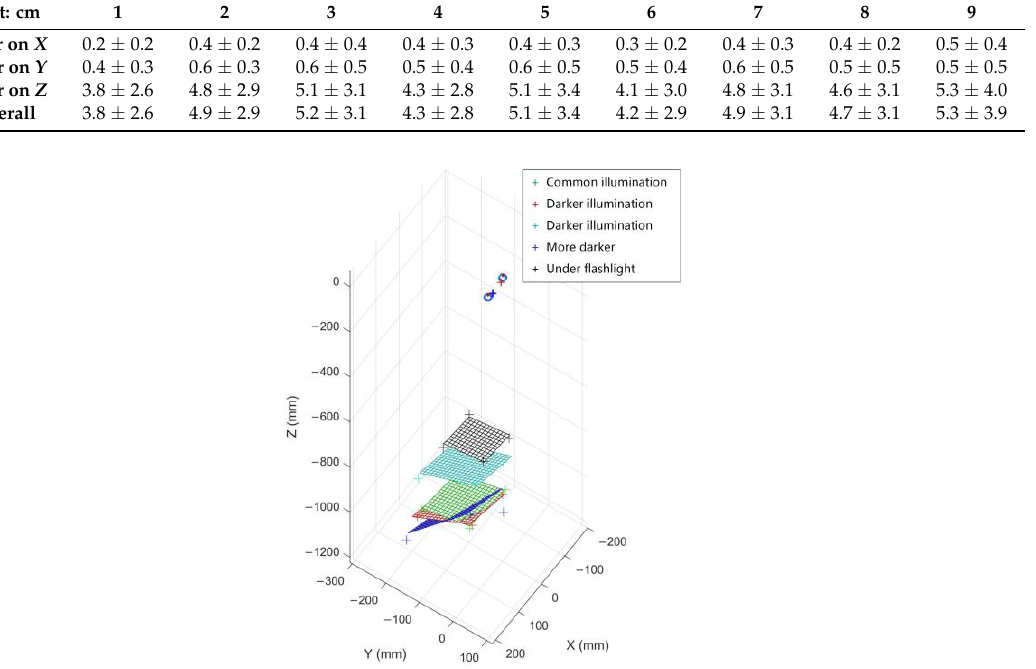
Figure 16. The graph shows the experimental result when the tester was watching the calibration board in five different illumination